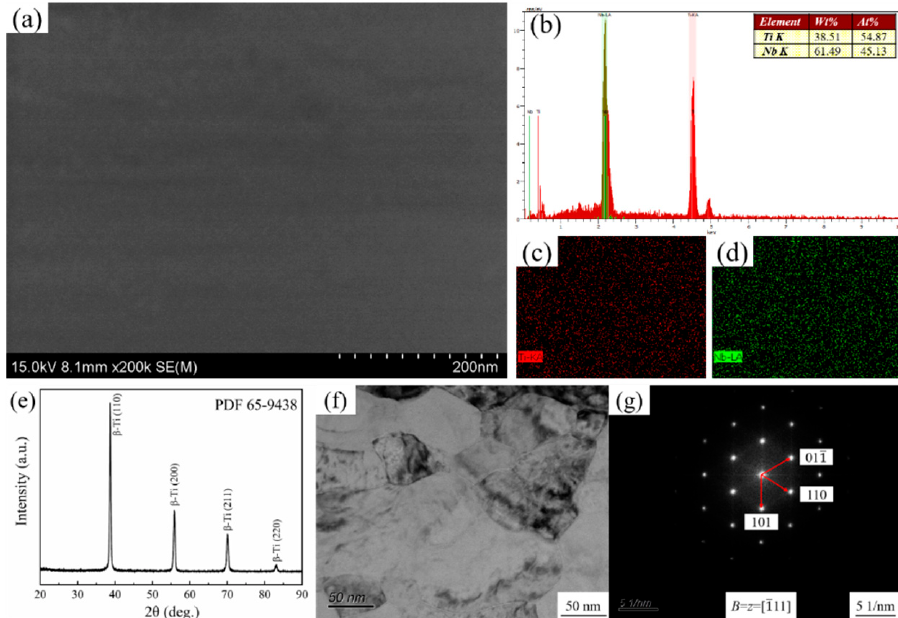
Figure 1. The SEM morphology and element compositions of Ti-45Nb alloy: ( a ) SEM, ( b ) EDS, ( c ) Ti-Mapping, ( d ) Nb-Mapping; ( e ) X-ray diffraction pattern of Ti-45Nb alloy; ( f,g ) TEM image of Ti-45Nb alloy and the selected area diffraction pattern.